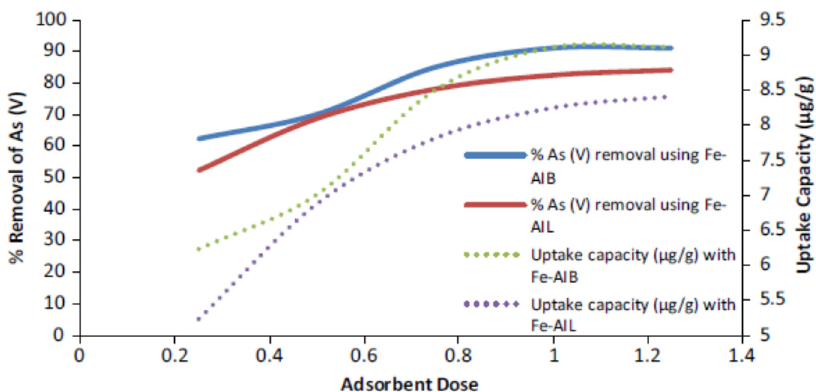
Figure 17. Effect of adsorbent dose on adsorption of As (V) by Fe-AIB and Fe-AIL. Reprinted from [25], ©2020 The Authors.